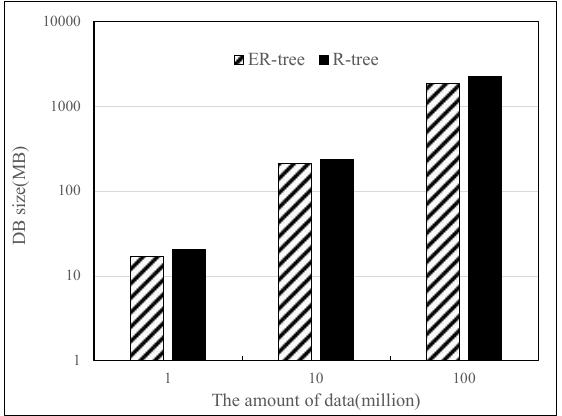
Figure 18. Comparison of index space.